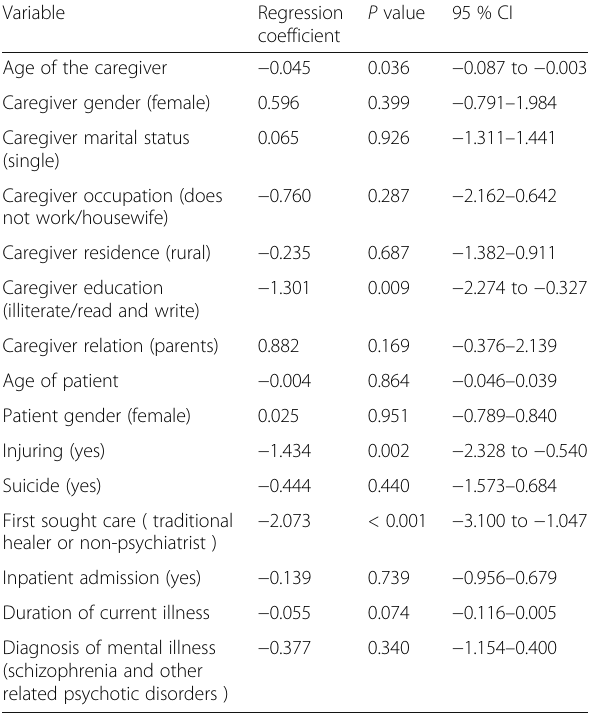
Table 5 Predictors of knowledge and attitude towards mental illness among the studied participants, Assiut